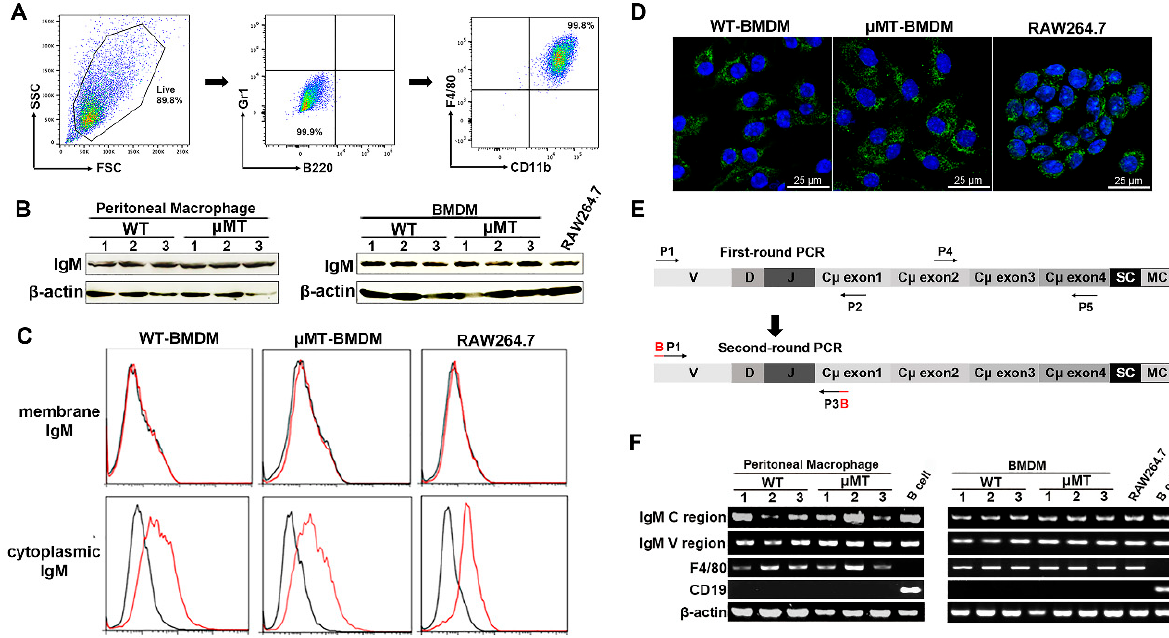
Figure 1. IgM expression in primary macrophages in adult mice and RAW264.7 cell line. ( A ) Purity of the isolated CD11b + F4/80 + cells validated by flow cytometry. The representative flow cytometry analysis of in vitro differentiated BMDMs from WT and μ MT mice demonstrate the purity of 99.9% and absence of B220 + B cells/Gr1 + granulocytes. ( B ) The mu heavy chain (IgM) was detected in peritoneal macrophages and BMDMs from WT and μ MT mice and RAW264.7 cells by Western blot with goat anti-mouse IgM polyclonal antibody. β -actin acted as an internal control. ( C ) Flow cytometry analysis using AF488 labeled goat anti-mouse IgM mAb showed that IgM was localized only in the intracellular space of BMDMs from WT and μ MT mice as well as RAW264.7 cells, but not on the plasma membrane of these cells. Black line, isotype control IgG1; red line, anti-mouse IgM. ( D ) Confocal microscopy analysis of BMDMs from WT and μ MT mice and RAW264.7 cells using goat anti-mouse IgM polyclonal antibody showed that IgM was present in the intracellular space. DAPI (blue) was used for nuclear staining. Scale bars, 25 μ m. ( E ) Diagrams (not to scale) of amplified DNA segments of IgM gene variable region and constant region by semi-nested PCR. The arrows indicate the positions of the listed primers in Table 1 used for amplification of the segments. ( F ) IgM gene rearrangement and transcriptions in sorted peritoneal macrophages and BMDMs from WT and μ MT mice and RAW264.7 cells were analyzed by RT-PCR. The sorted CD19 + B cells were used as the positive control. F4/80 as macrophages-specific marker and CD19 as B cells markers were amplified. B, barcodes for primers to differentiate various samples in the next-generation sequencing; MC, membrane component; SC, secreted component; and β -actin as an internal control. Next, we analyzed IgM transcripts by RT-PCR in CD11b + F4/80 + macrophages from both WT and μ MT mice. We first used the primers to amplify constant region transcripts of IgM heavy chain. We then found that the constant region transcripts of IgM were mark- edly demonstrated in these macrophages (Figure 1E,F). The characteristic sequence of functional Ig transcripts is its variable region presenting typical V (D) J rearrangement. As expected, we also determined the IgM transcripts with a typical VDJ rearrangement of the variable region in the primary peritoneal macrophages and BMDMs from either WT or μ MT mice, as well as in RAW264.7 cells (Figure 1E,F). The results indicated that macro- phages expressed IgM, mainly located in intracellular compartments but not on the cell surface. 3.2. The Repertoire of IgM Heavy Chain Variable Region Sequences Displays Restricted Diversity in Macrophages It has been reported that rearranged IgM variable region was expressed in a small macrophage subfraction, which showed markedly restricted Ig repertoires compared to normal B cells [16]. In this study, we further analyzed the rearranged sequences of IgM V H DJ H in BMDMs of three WT and three μ MT mice, as well as in the RAW264.7 cells, by next-generation sequencing. The B cell-derived IgM served as a positive control. We ob- tained 8911 reads of IgM transcripts in BMDMs of WT mice, 3175 reads of IgM transcripts